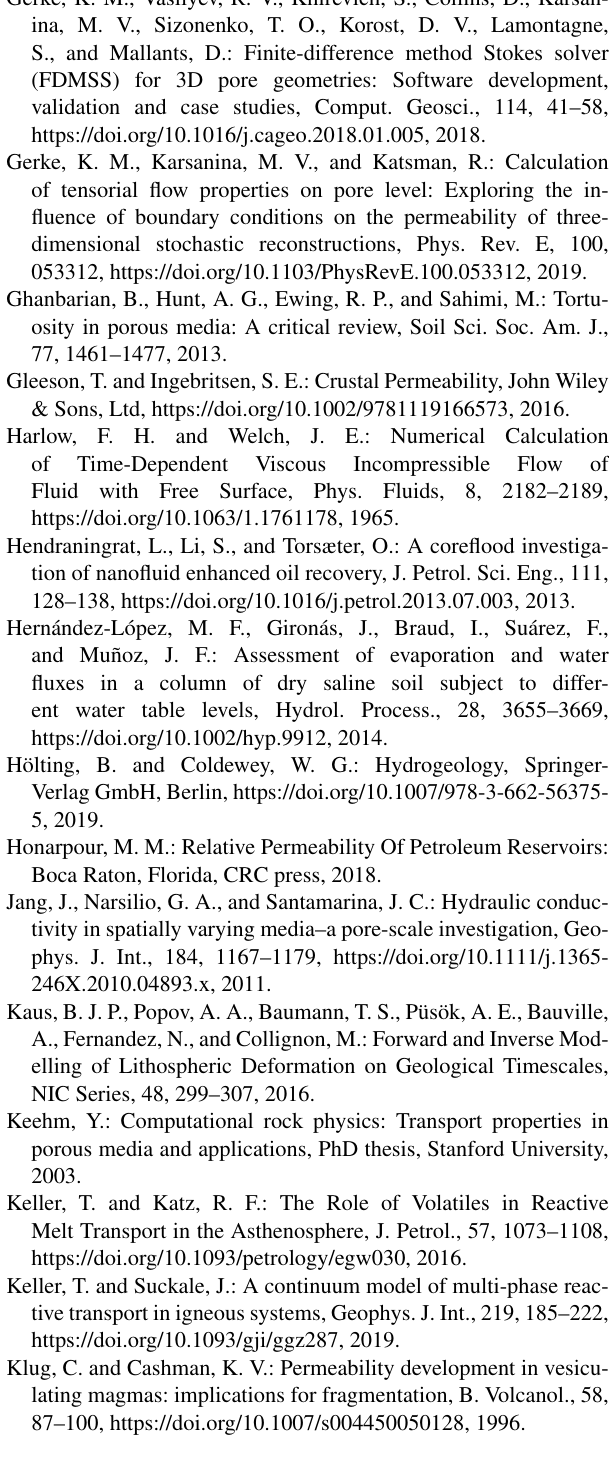
Figshare, https://doi.org/10.6084/m9.figshare.11378517,